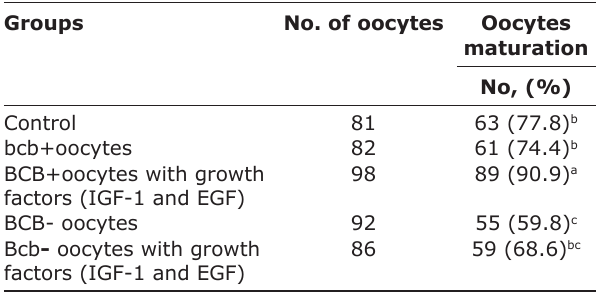
Table-1: Effect of growth factors addition during IVM on maturation rate of BCB selected oocytes.